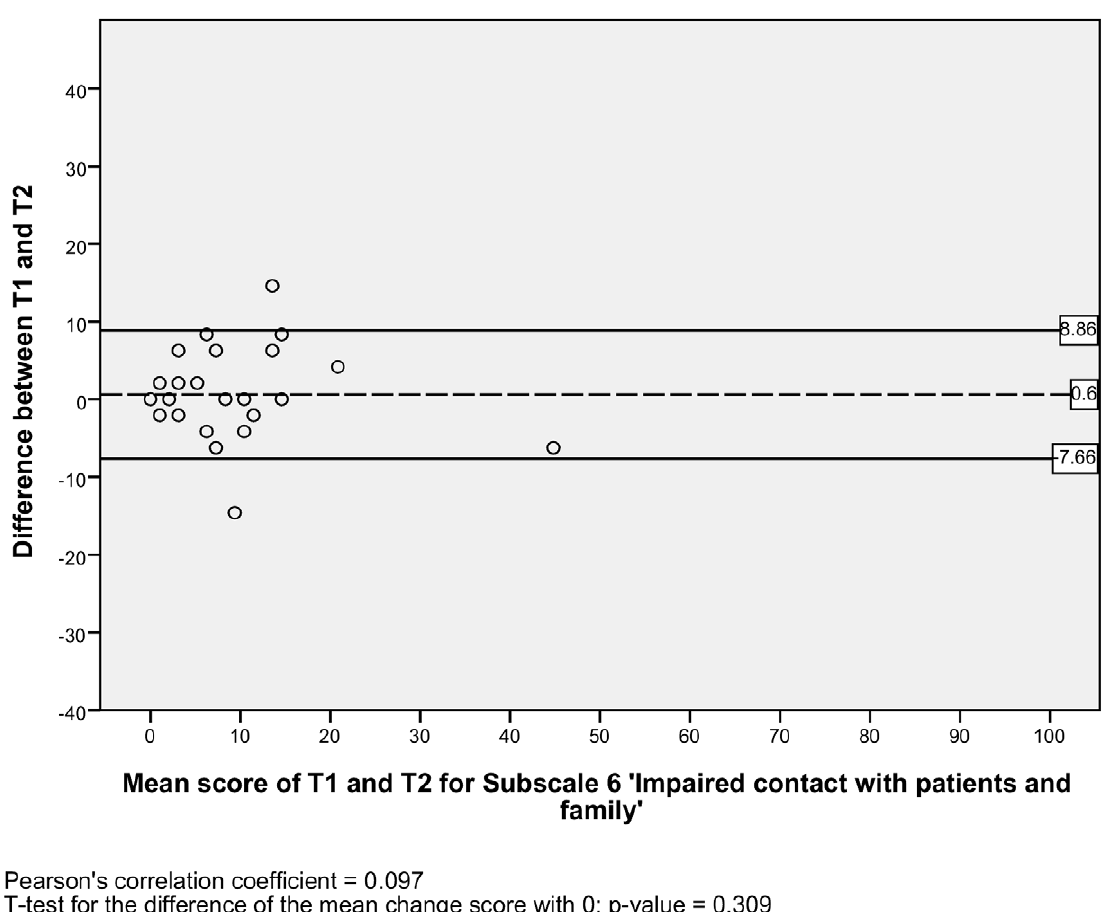
Figure 6. Bland and Altman plot for subscale 6 ‘Impaired contact with patients and their family’.